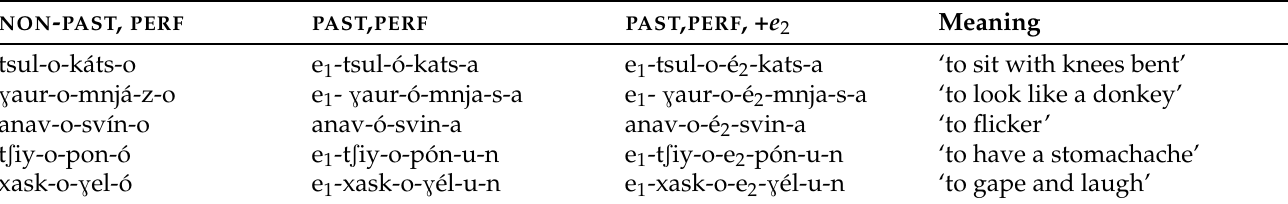
Table 4. Verbal complexes with two-syllable verb stems.